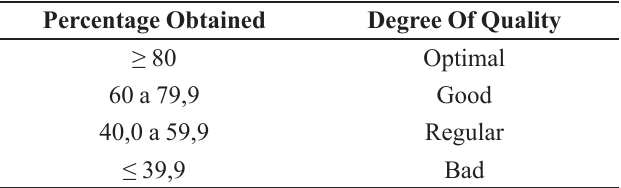
TABLE II - Matrix for value judgment of quality of the pharmaceutical services in HIV/AIDS in Niterói,